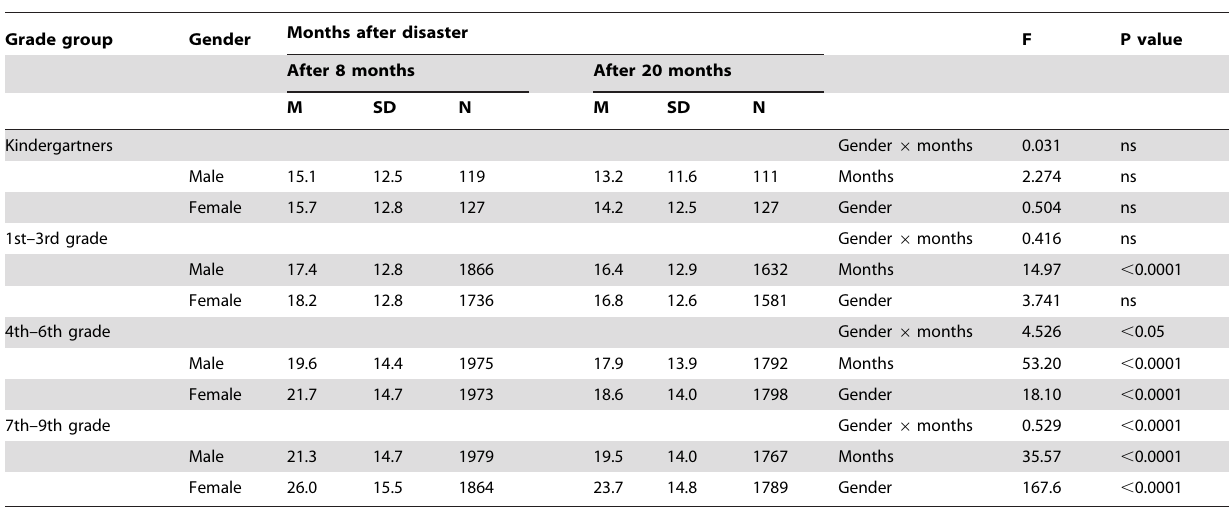
Table 4. Average PTSSC-15 score (grade, gender, and month)